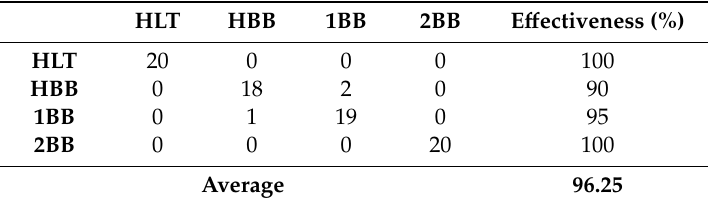
Table 5. E ff ectiveness percentage for the proposed methodology (Confusion